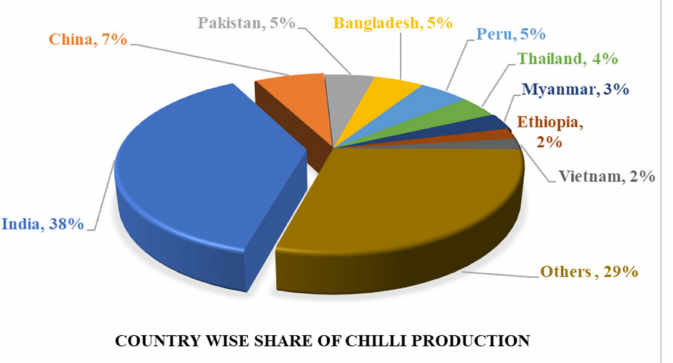
Figure 1. Country-wise share of chilli production extracted from www.faostat.fao.org (accessed